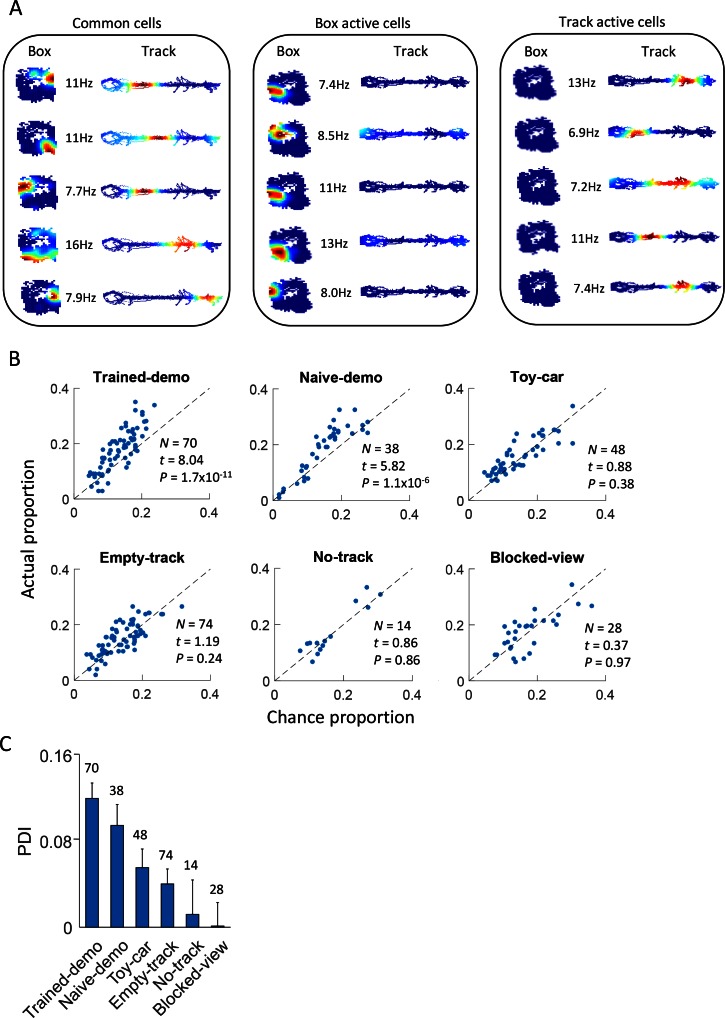
Common cells were cross-activated during rotation events in the box and during lap-running events on the track.(A) Example rate maps of common cells, those active during rotation only, and those active during lap-running only, in the same rat under the Trained-demo condition. Each row of color plots shows firing rate maps (firing rate versus position) of a cell during rotation events in a Post-box session and that of the same cell during lap-running events on a track trajectory. Numbers: peak rates. (B) Scatter plot of actual proportion versus chance proportion of common cells under different box conditions. Each dot represents a pairing between a box (either Pre- or Post-box) session with one of the two track trajectories on the same day (there could be up to 4 dots on each day). Dashed line: line of equal actual and chance proportion values. N: number of pairings between box sessions and track trajectories; t, P: paired t-test statistics and p value between actual and chance proportions. (C) Average PDI across box sessions under each observation condition. F(5,267) = 11, p=0, one-way ANOVA across all conditions. Number above each bar: number of pairings between box sessions and track trajectories.